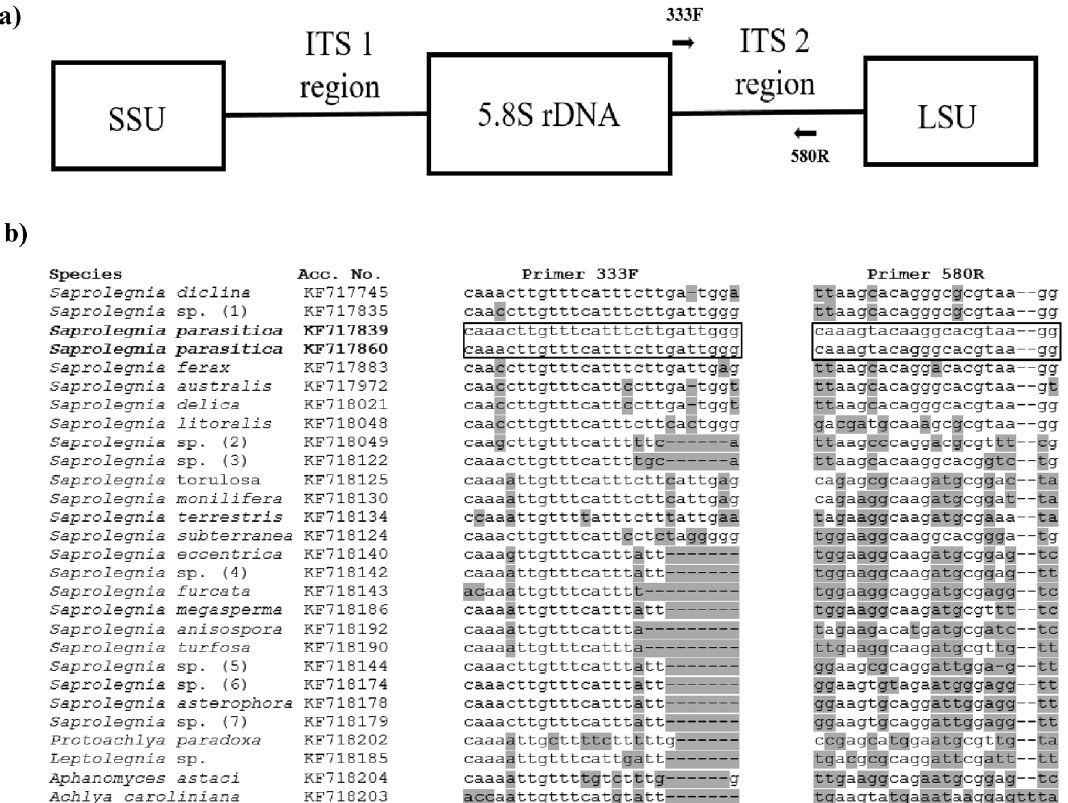
Figure 1. ( a ) Position of Saprolegnia parasitica -specific primers 333F and 580R in the internal transcribed spacer (ITS) region (including ITS 1, 5.8S rDNA, and ITS 2) between small subunit (SSU) and large subunit (LSU) rDNA. ( b ) Multiple sequence alignment (MSA) of primer sequences and ITS 2 segments of a range of Saprolegnia spp. and other oomycetes. Primer sequences are framed, with a degenerate position (A/G) in the primer 580F marked in bold. Nucleotides that differ between S. parasitica and other species within a particular MSA column are shaded in grey. Acc. No.—Genbank accession numbers.